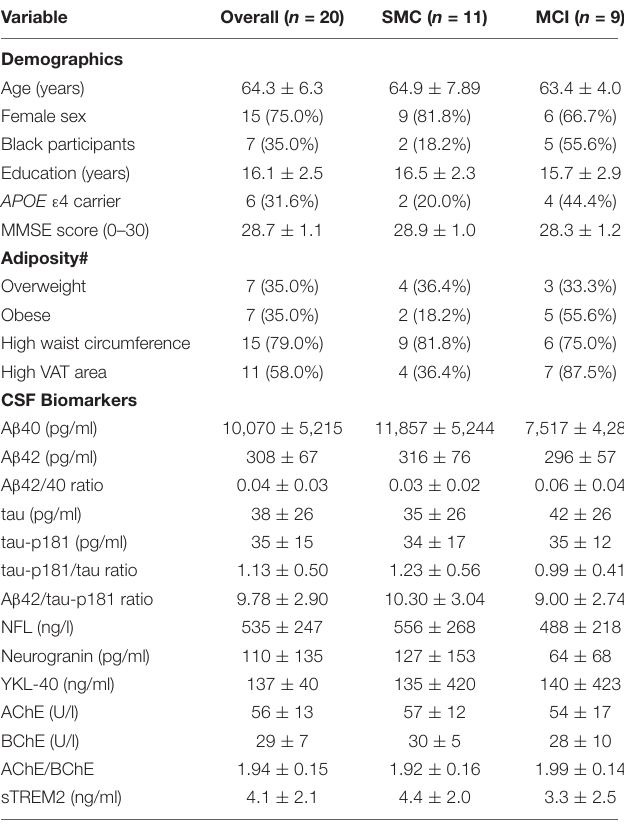
TABLE 1 | Baseline characteristics overall and stratified by cognitive